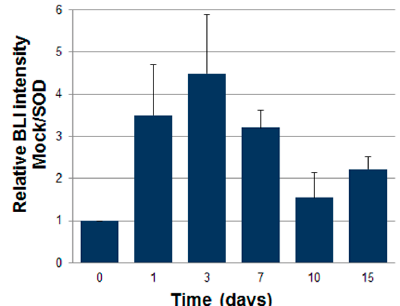
Figure 3. Luciferase positive SOD2 -expressing ASCs display improved ability to withstand hypoxia in vitro. Murine ASCs expressing luciferase were transduced with LV vectors expressing either GFP as mock control or SOD2 and cultured in hypoxic conditions. ( A ) BLI analysis was performed at three days of culture and intensity of bioluminescence was determined. Data are expressed as the ratio of the BLI signal of the SOD2 group vs. mock control group. Data are expressed as mean ˘ SEM of three different independent experiments performed in duplicate. The asterisk indicates a significant difference determined by unpaired Mann–Whitney U test ( p < 0.05); ( B ) A representative BLI analysis and quantification of ASCs cultured in hypoxic condition for three days.